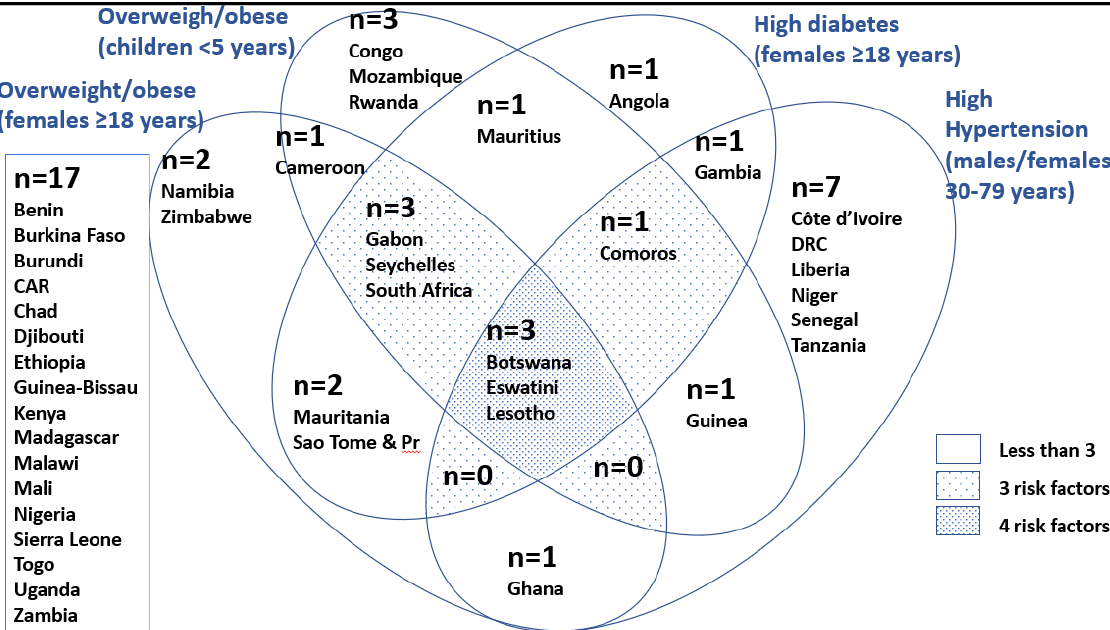
Figure 8. A Venn diagram showing evidence of the epidemiological transition in SSA countries (only those in the top tertile are in the diagram, i.e., 17 are not).